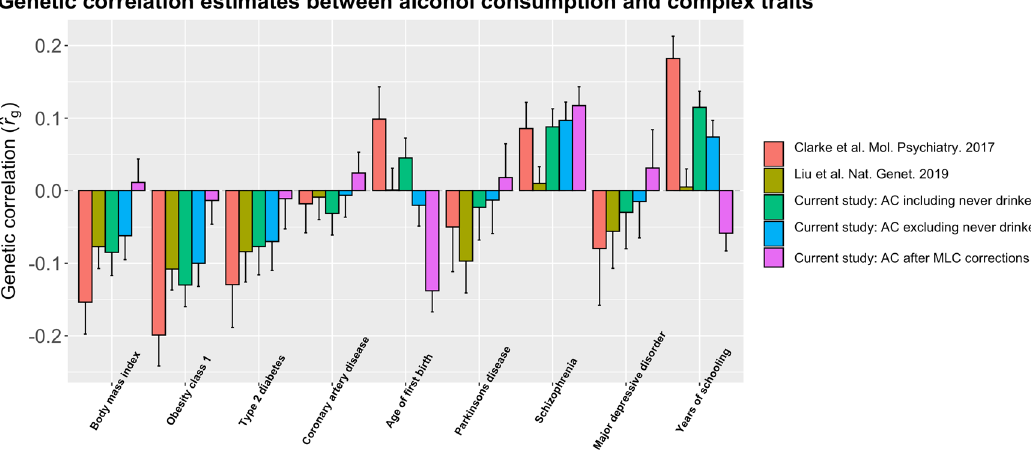
Fig. 3 Estimates of genetic correlation between AC and complex traits using data from the UKB and other published studies. Genetic correlation was estimated by the bivariate-LDSC in LD Hub. The y-axis shows the estimate of r g , and the x-axis shows different complex traits. The error bars denote the standard errors of the estimates. The results using the summary statistics from our analysis were compared to those from Clarke et al. 4 , who used self- reported AC from the interim release of the UKB data, and Liu et al. 5 , a meta-analysis that included the full release of the UKB data. The sample sizes of the fi ve AC data sets are 112,117 (Clarke et al.), 941,280 (Liu et al.), 372,897 (including never drinkers), 358,409 (excluding never drinkers), and 336,469 (after the MLC corrections), r was slightly underestimated but with no bias in the direction in b the presence of disease ascertainment, and that the MLC corrections did not induce any bias in ^ r under the null b ¼ 0 (Supplementary Fig. 9). hypothesis that r b